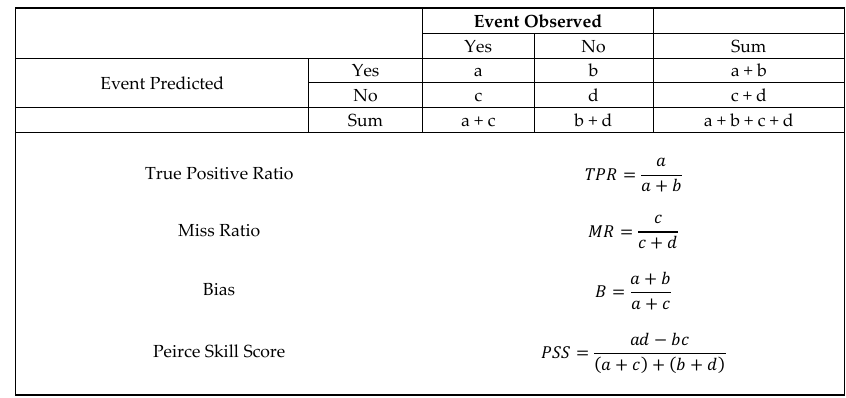
Atmosphere 2018 , 9 , x FOR PEER REVIEW Table 2. Contingency table verification measures used in this study. Table 2. Contingency table verification measures used in this